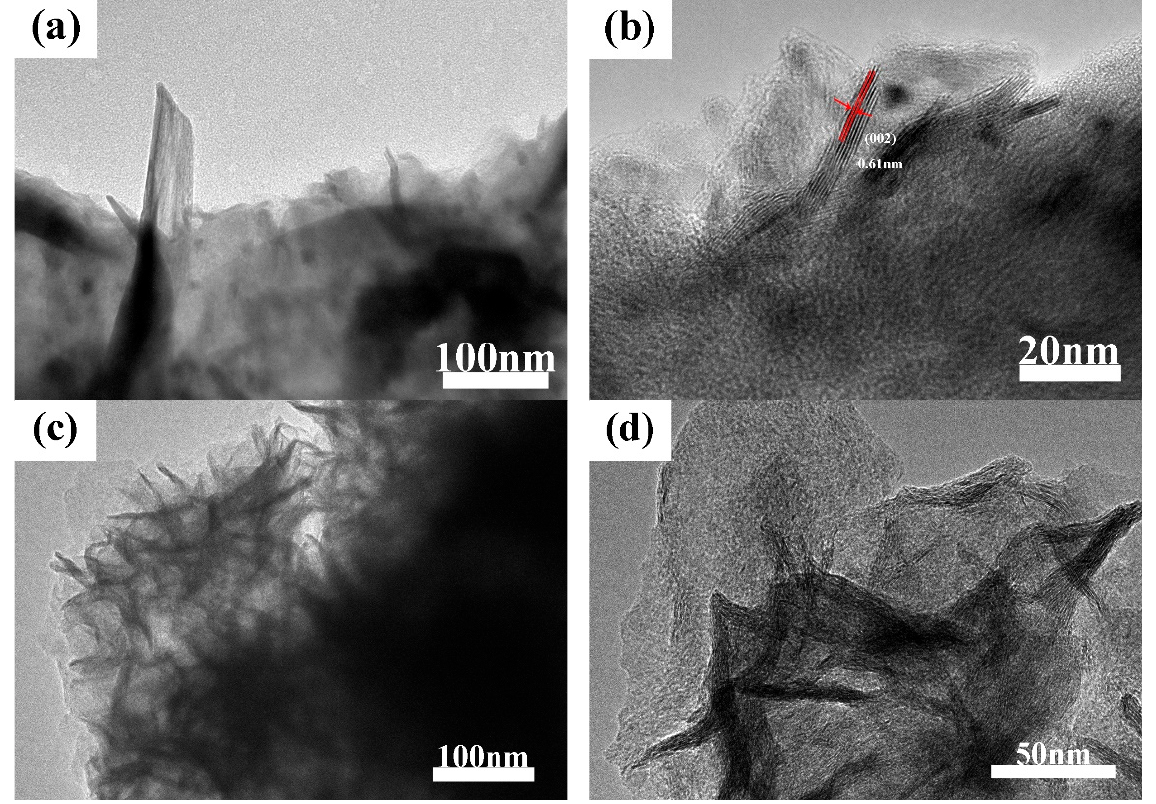
Figure 4. TEM images of MoS 2 /biocarbon obtained by DIC method ( a , b ) and by IHC method ( c , d ) under different magnification.